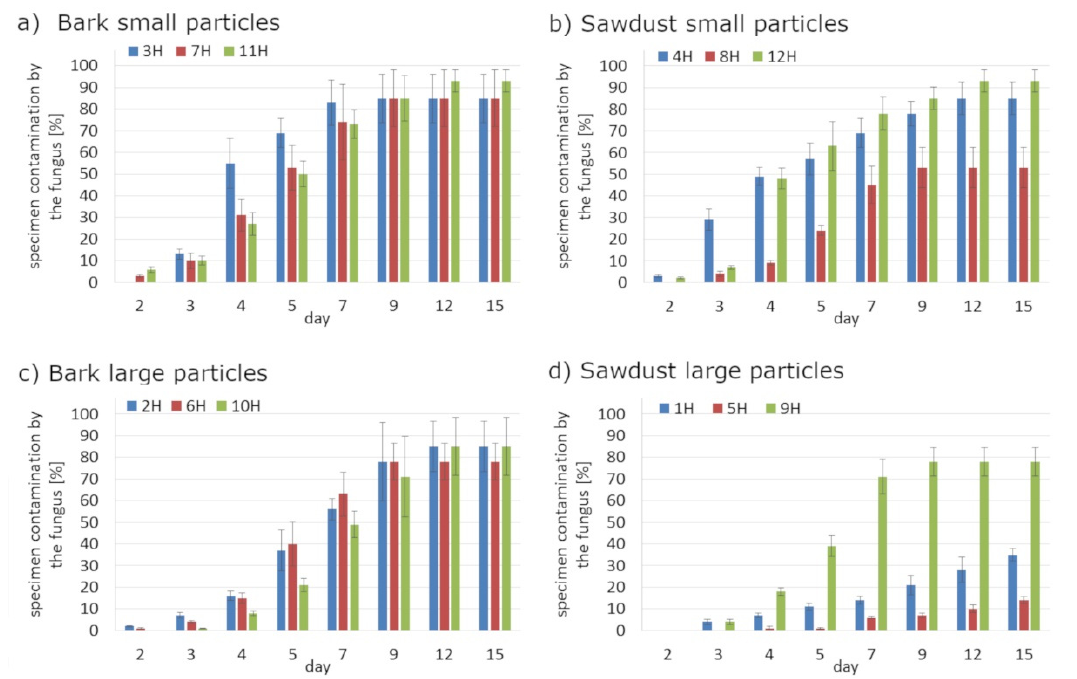
Figure 1. The rate of surface fouling by Aspergillus niger Tiegh fungi on PLA composites for: ( a ) bark small particles; ( b ) sawdust particles; ( c ) bark large particles; ( d ) sawdust large particles.